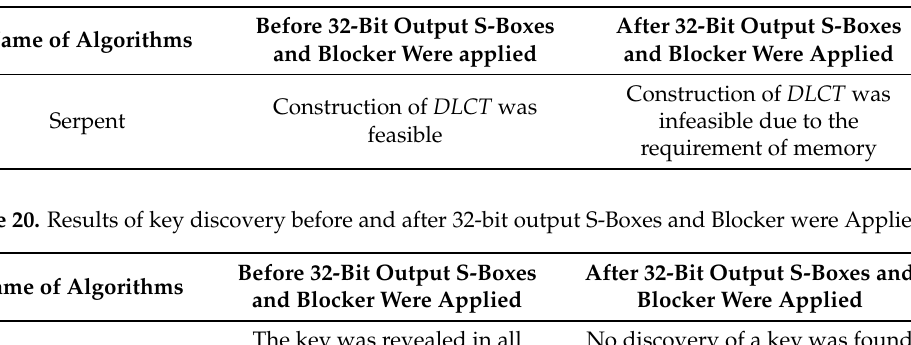
Table 19. Results of feasibility of constructing DLCT before and after 32-bit output S-Boxes and Blocker were applied.